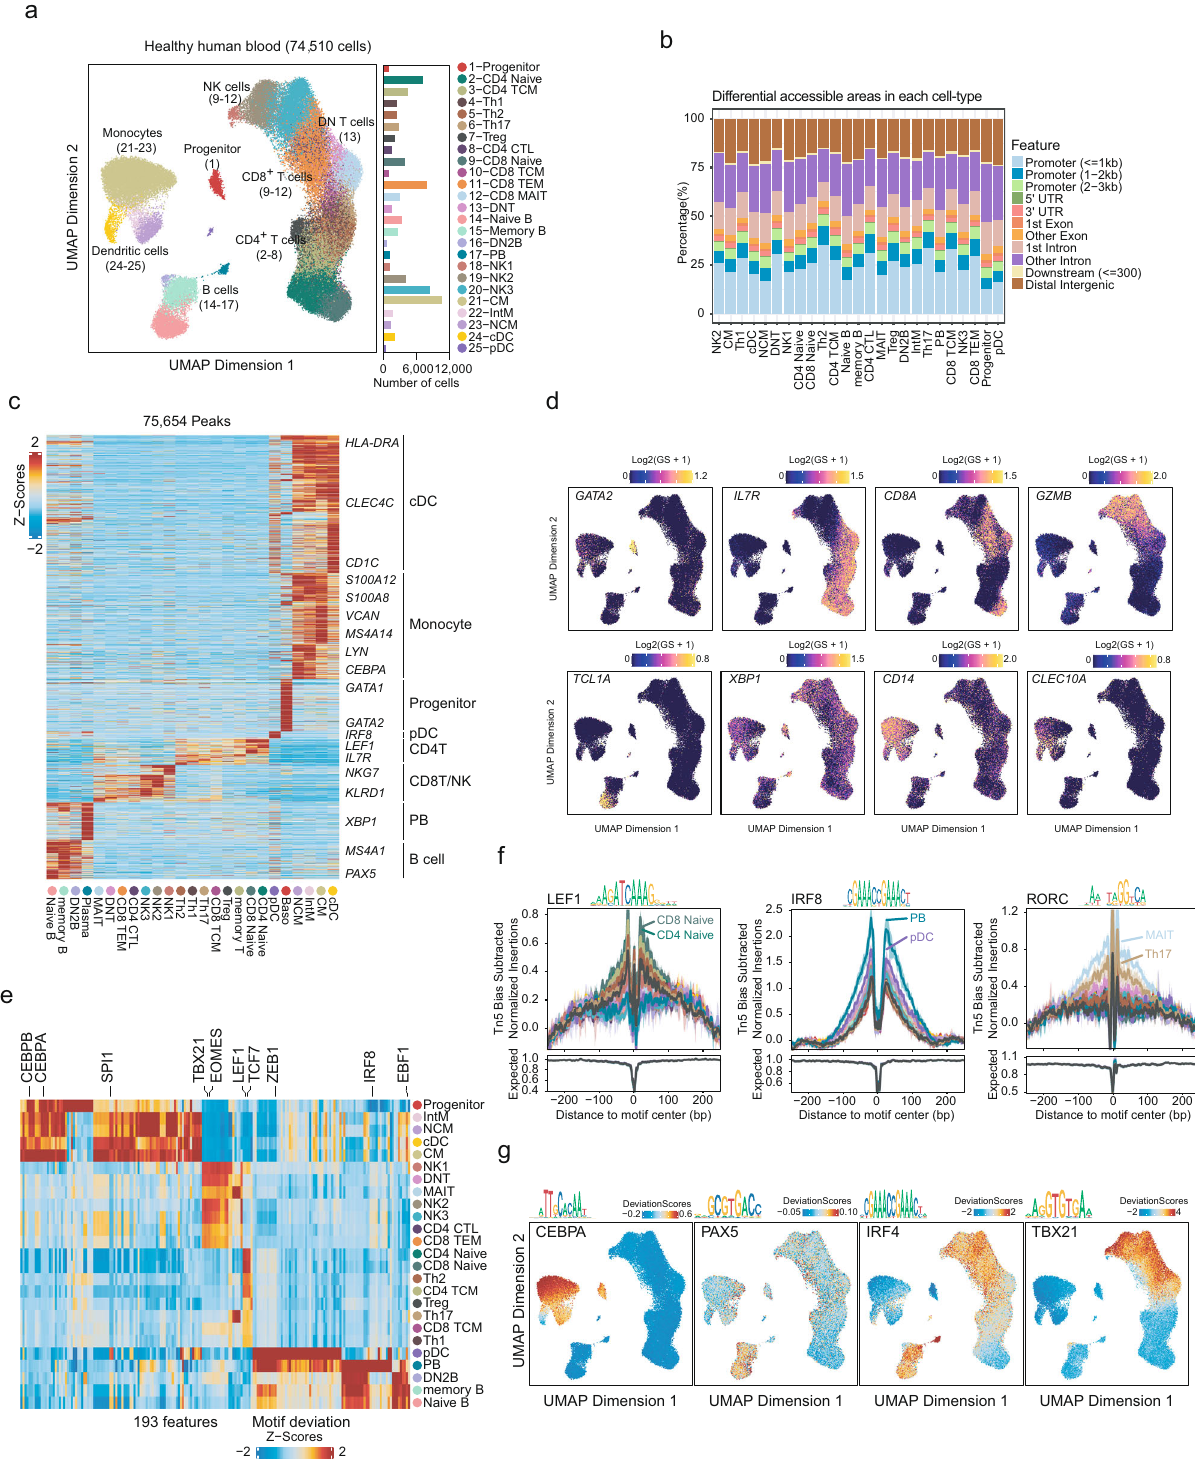
Fig. 2 Single-cell chromatin landscape of health human peripheral immune cell subsets. a UMAP projection of 74,510 scATAC-seq pro fi les of peripheral blood immune cell types from 12 healthy controls. Dots represent individual cells, and colors indicate immune cell types (labeled on the right). Bar plot indicates the number of scATAC-seq pro fi les in each cell types. b Bar plot of annotated DAR locations for each cell type. c Heatmap of Z-scores of 75,654 cis-regulatory elements in scATAC-seq peripheral blood cell types derived from Fig. 2a. Gene labels indicate the nearest gene to each regulatory element. d UMAP projection colored by gene activity scores for the annotated lineage-de fi ning genes in HC group of scATAC-seq dataset. The minimum and maximum gene activity scores are shown in each panel. e Heatmap representation of chromVAR bias-corrected deviations in the most variable TFs across all healthy immune cell types. f TF footprints with motifs in the indicated scATAC-seq healthy immune cell types. The Tn5 insertion bias track is shown below. g UMAP projection of scATAC-seq peripheral blood pro fi les colored by chromVAR TF motif bias-corrected deviations for the indicated factors. All data are aligned and annotated to hg38 reference